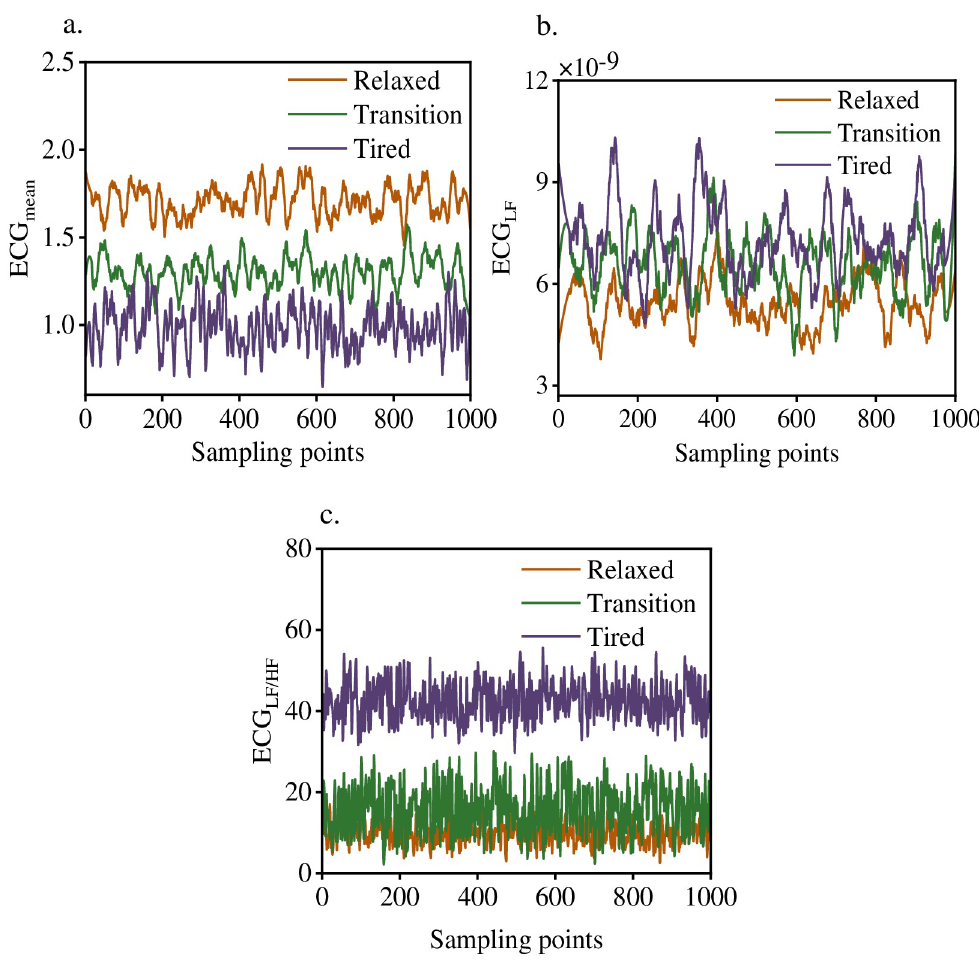
Fig 8. ECG signal characteristic